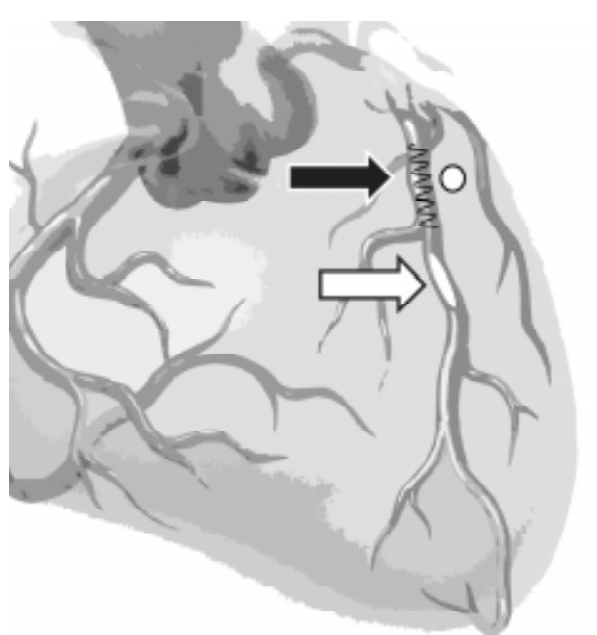
Figure 1. Coronary arterial biopsy site. Arrows: black = stent site; white = Coronary arterial biopsy site; circular = myocardial biopsy site .